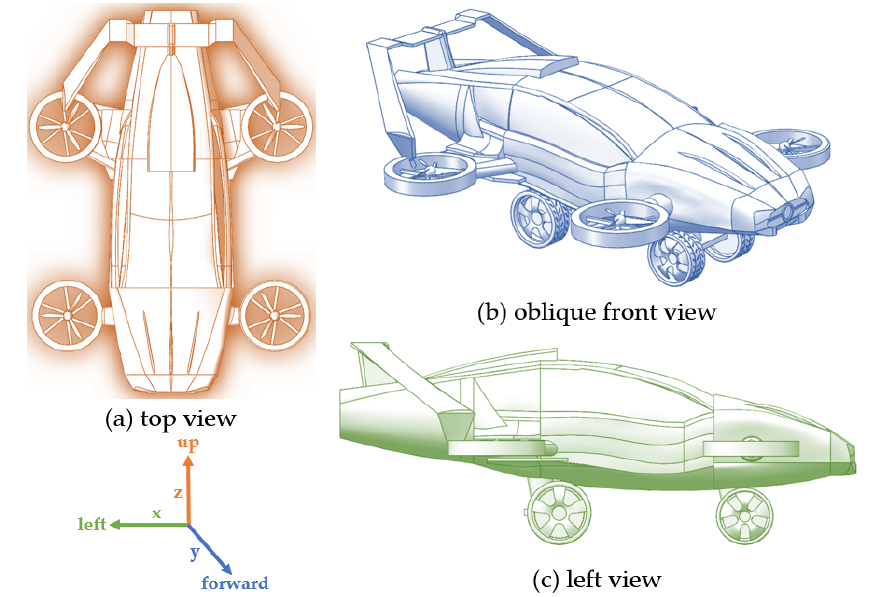
Figure 1. Three views of hybrid air–ground aircraft in different directions.